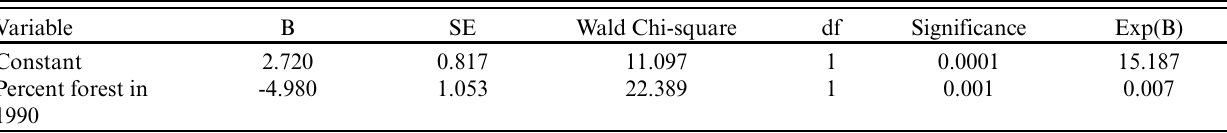
Table 1 . Results of a stepwise logistic regression analysis performed using 12 independent variables to explain changes (0 = no change, 1 = conversion to other land use) in forest cover in the Pixquiac and Gavilanes watersheds during the period 1990–2003. See the text for a description of each variable.